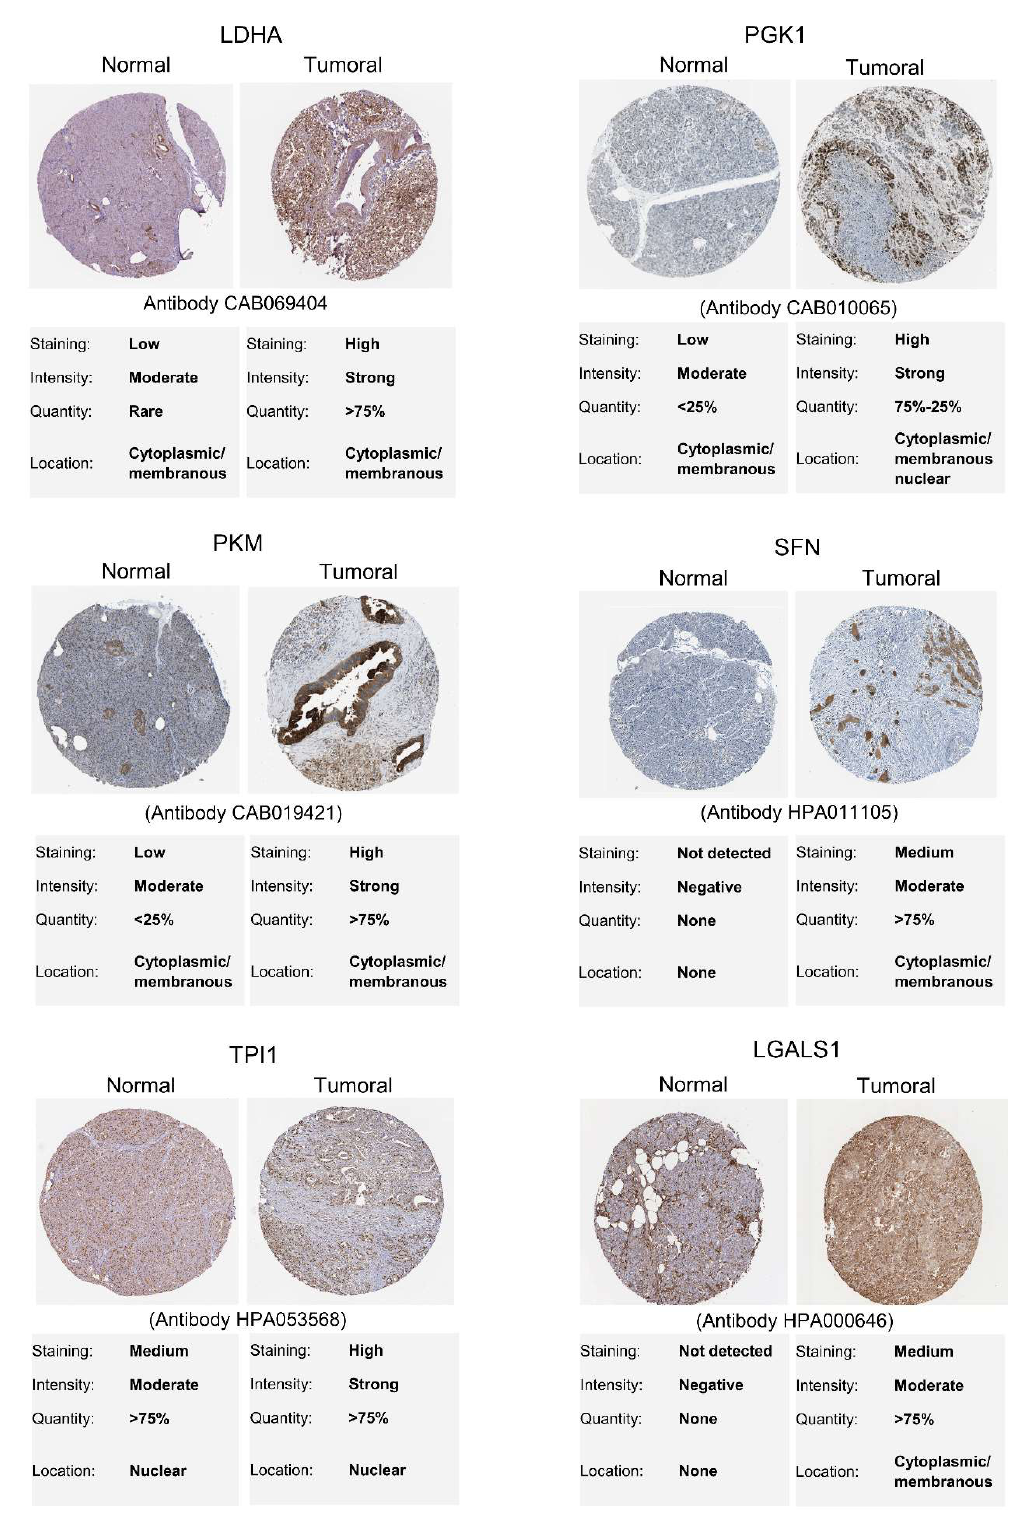
Figure 9. Identification of secreted proteins in normal and pancreatic ductal adenocarcinoma (PDAC) tissues using immunohistochemical staining data available at the Human Protein Atlas database [116]. These proteins were selected based on their significant increased gene expression, as identified using the GEPIA tool [105].